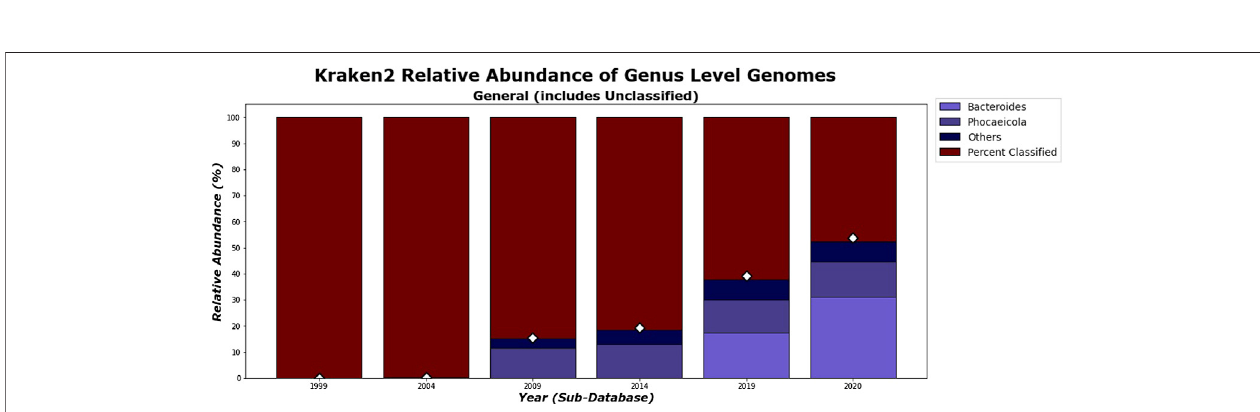
FIGURE10 | CLARK ’ s generalrelativeabundance for Genus Level. Only taxa whose generalrelativeabundance was at least 3%are shown asa colored bar here. A bar for the Unclassi fi ed group is included. The percentage of classi fi ed reads for each year are shown as diamond markers.